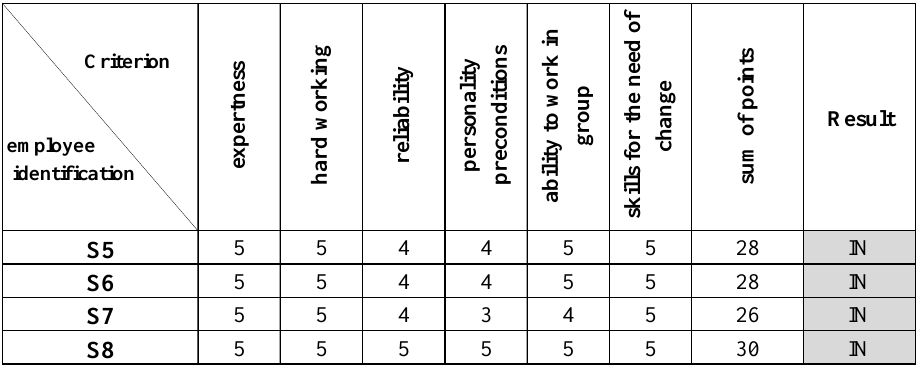
Table 8 – Evaluation of criteria by Head of warehouse no.